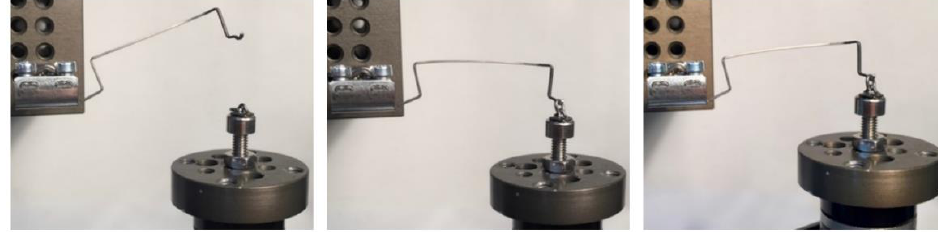
Figure 5. The three relevant positions of the cantilever during the measurements showed by the example of a 6 mm high utility arch. Left: neutral. Middle: activated. Right: 3 mm deactivated.